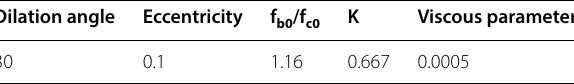
Table 8 Parameters in damage plasticity model.